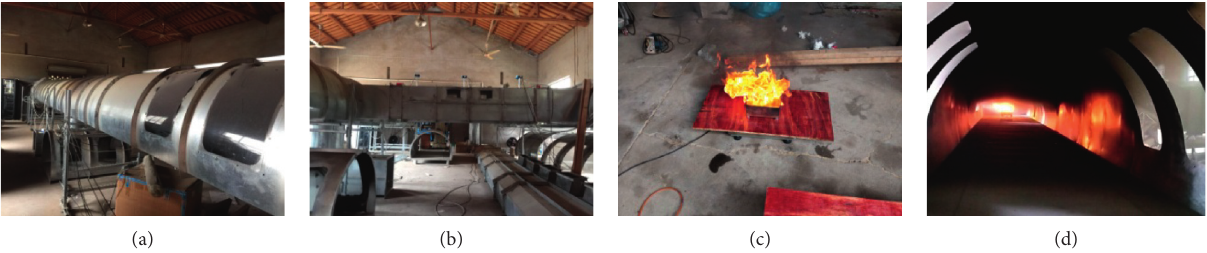
Figure 8: (a) Model of tunnel. (b) Model of cross channel. (c) Testing the heat release rate of fire source. (d) Testing the smoke diffusion when a fire occurs in a two-lane